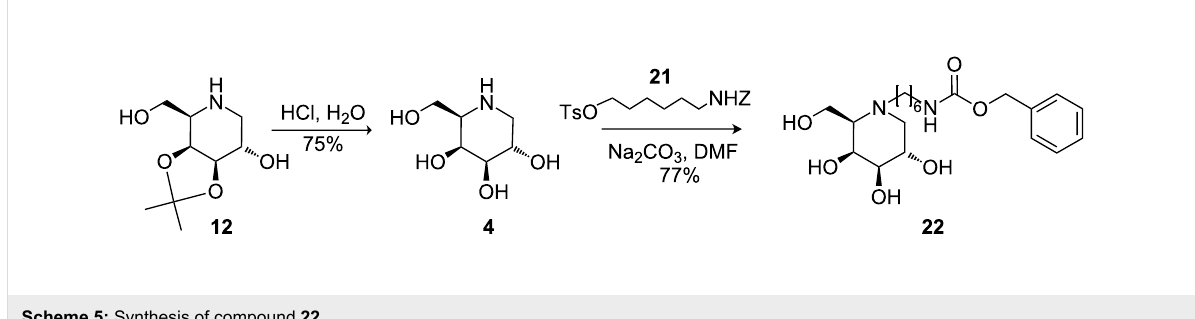
Scheme 5: Synthesis of compound 22 .